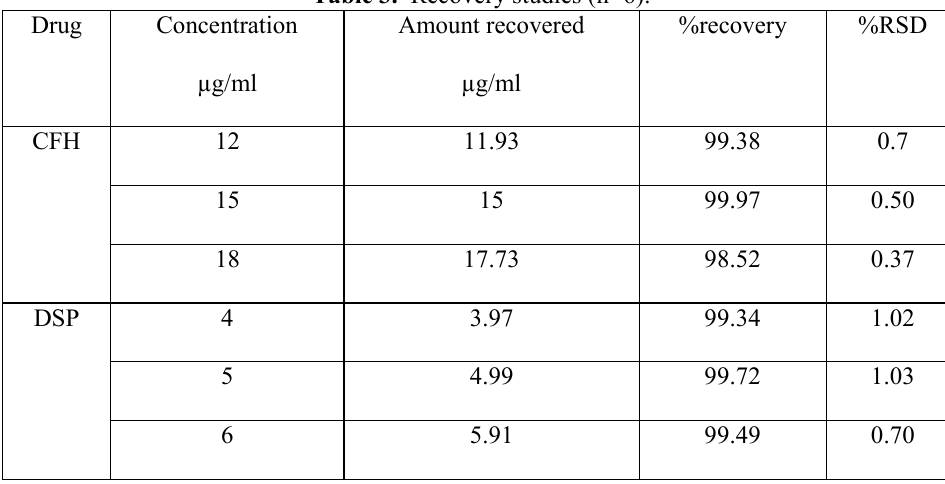
Table 3. Recovery studies (n=6).